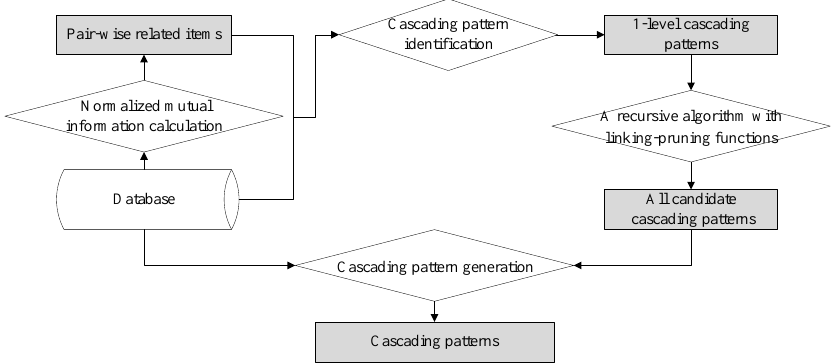
Figure 1. Normalized-mutual-information-based mining method for cascading patterns Workflow. Table 2. Structure of normalized mutual information contingency table.